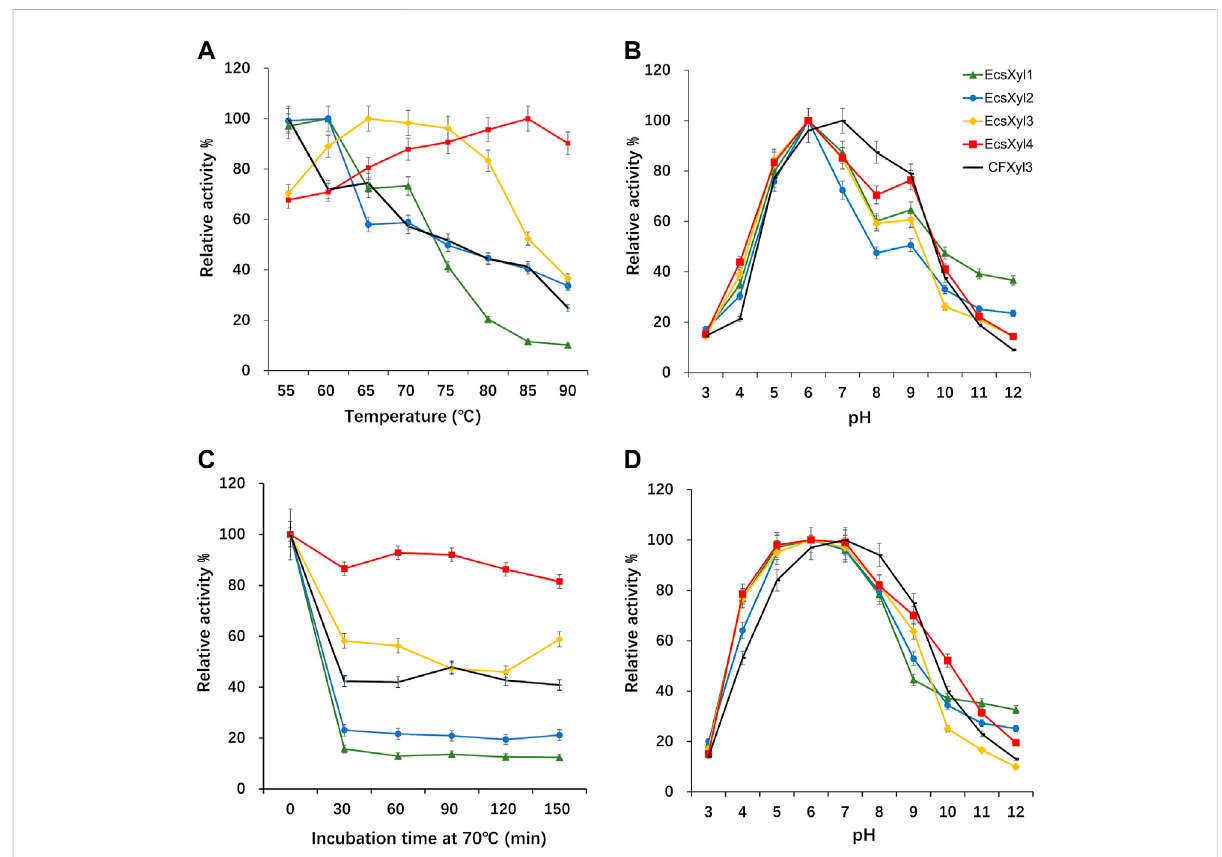
FIGURE 4 In fl uence of thetemperatureand pH on CFXyl3 and EcsXyl1 – 4xylanases, thermal and pH stabilities. (A) : Optimal temperature; (B) : Optimal pH; (C) : Thermal stability at 70 ° C; (D) : pH